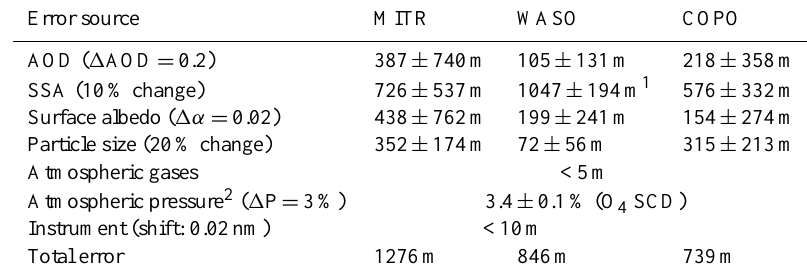
Table 6. Summary of error sources and total error budget for the AEH